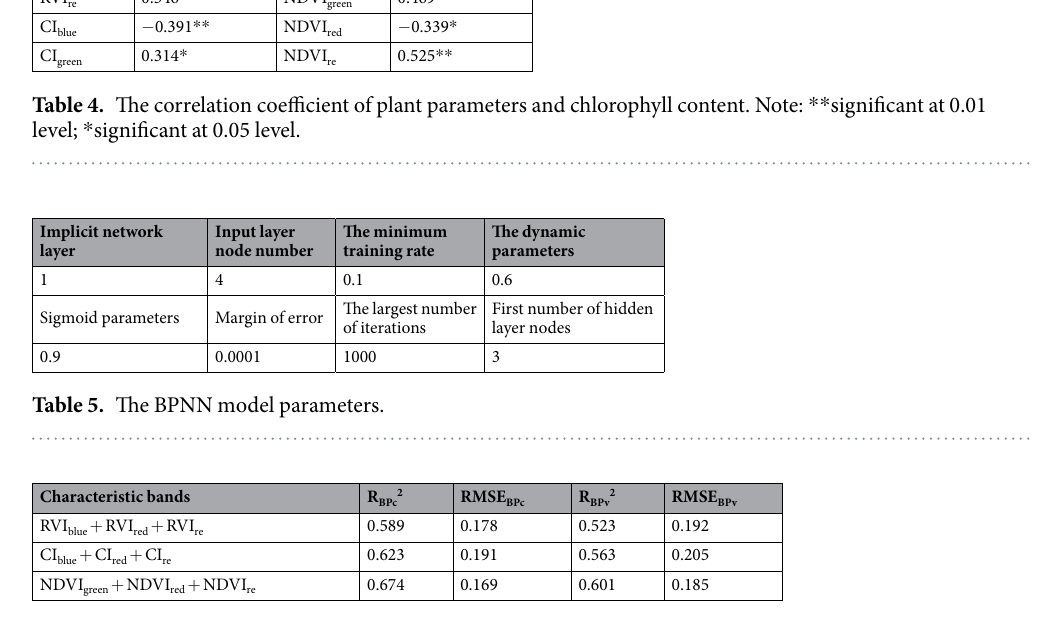
Table 6. The BPNN models for estimation of chlorophyll content based on vegetation indices. Note: R BPc2 was the determination coefficient of the BPNN model; R BPv2 was the verification determination coefficient of the BPNN model; RMSE BPc was the root mean square error of the BPNN model; and RMSE BPv was the verification root mean square error of the BPNN